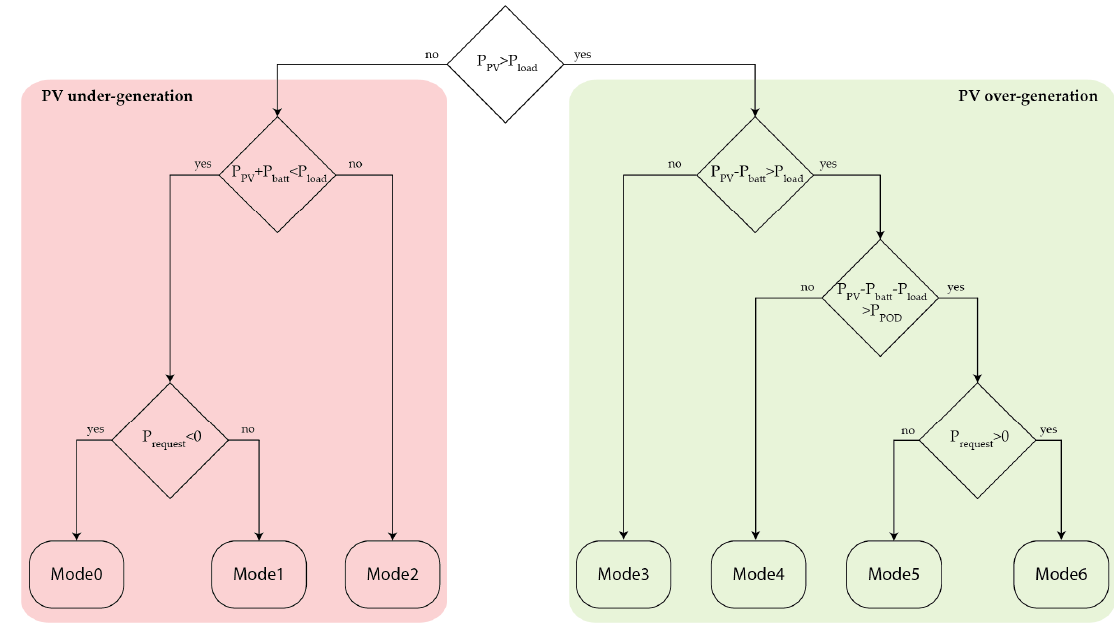
Figure 5. Flow chart of DBS modes.